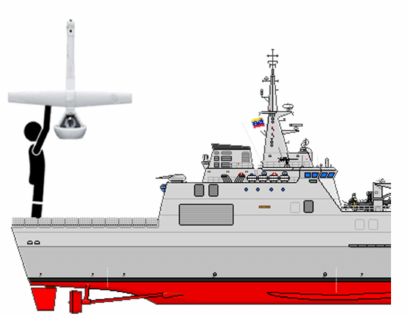
Figure 1. The manual landing process of the DUAV system on a ship deck.